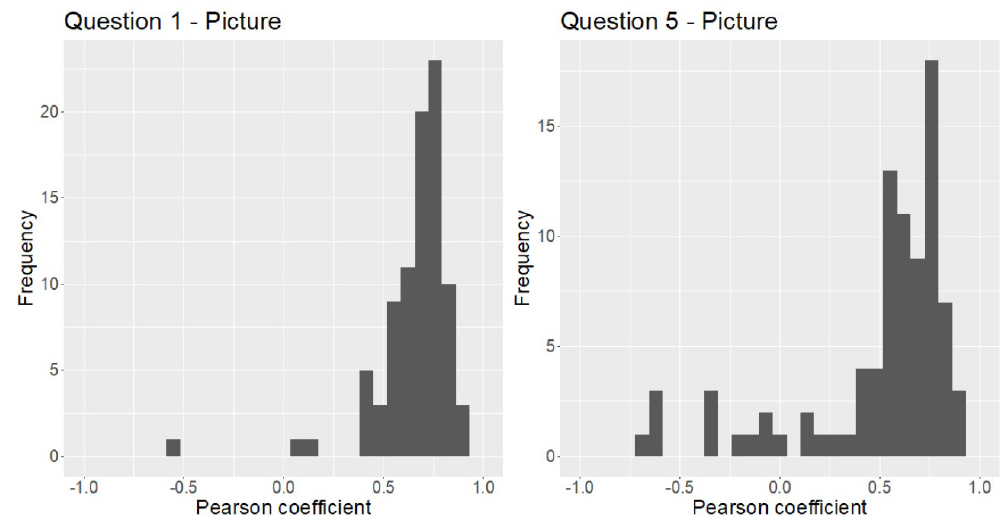
Figure 4. Histogram of Pearson correlation coefficients for each question, considering the 87 people analyzed in the pictures